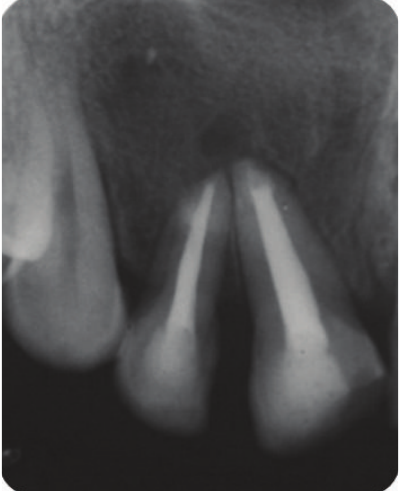
Figure 45: 12-month follow-up IOPA radiograph.